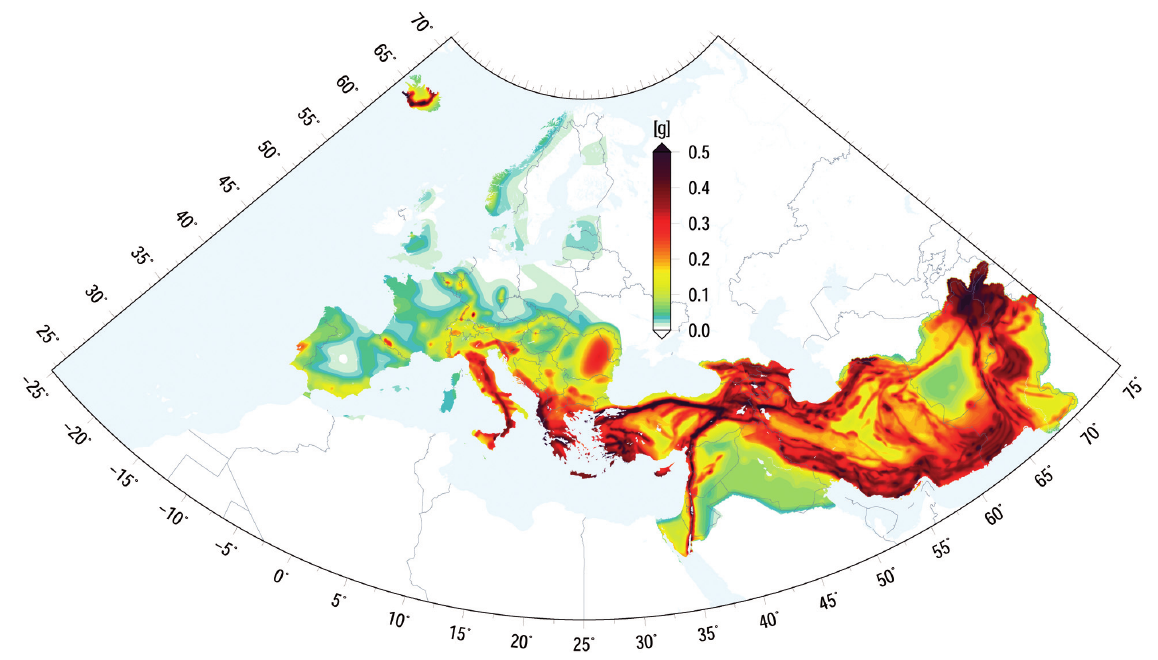
Figure 5. Harmonized seismic hazard map displaying the 10% exceedance probability in 50years for peak ground acceleration (PGA) span- ning the regions of Europe and Middle East. The seismic hazard maps for EMCA target region was produced in terms of Macroseismic in- tensity, hence not reproduced